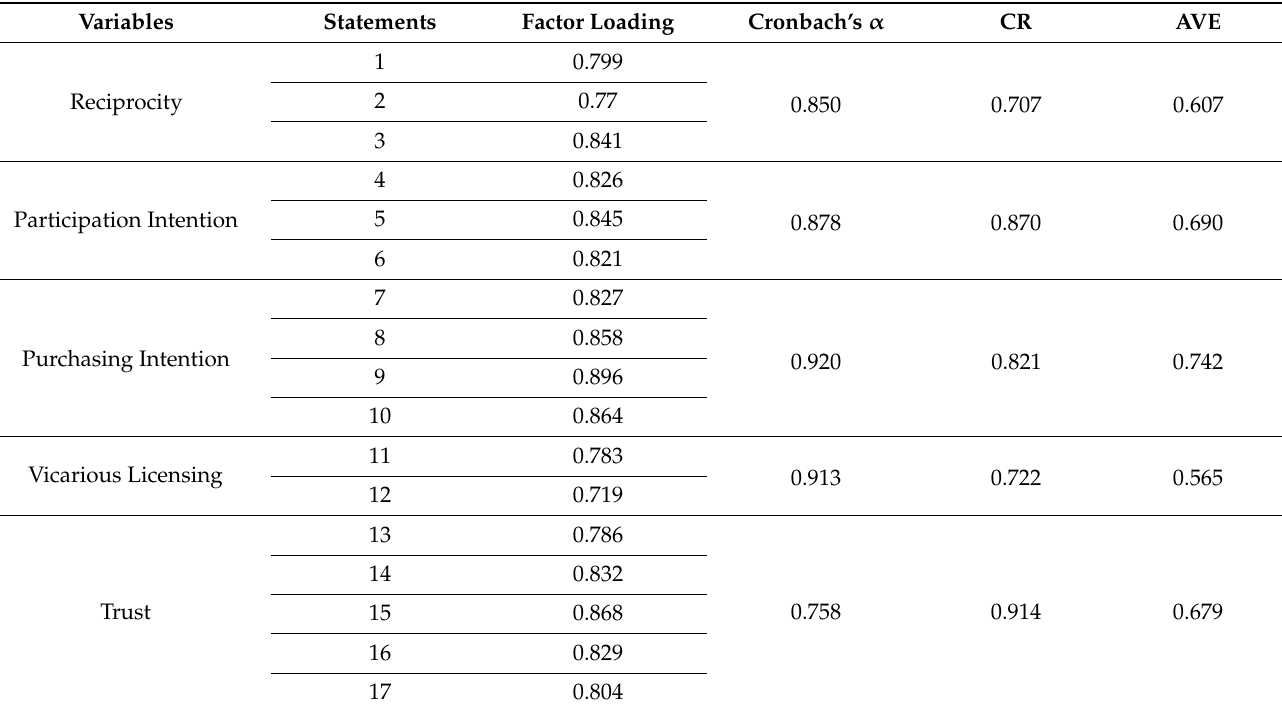
Table 1. CFA (Confirmatory Factor Analysis) outputs.